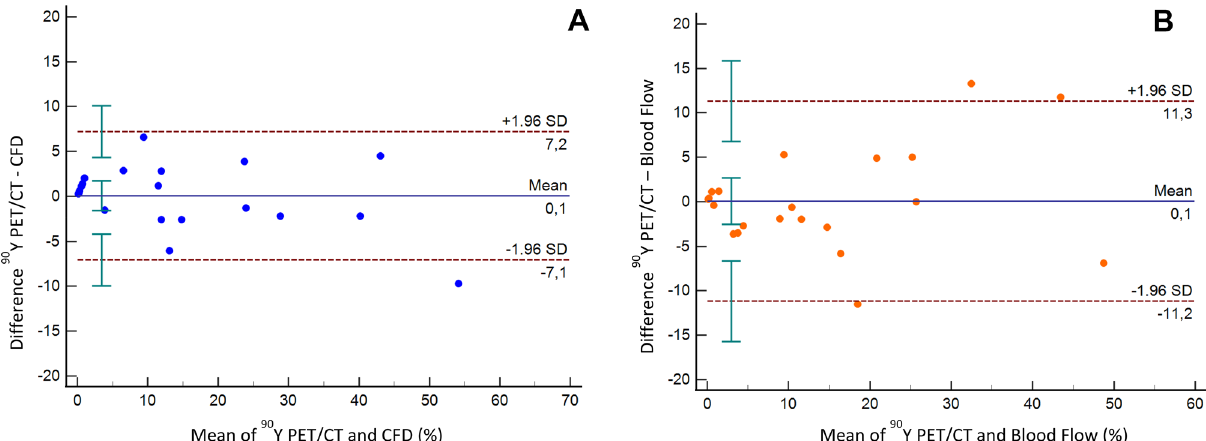
Figure 8. Bland–Altman plots for the differences in distribution in the 21 liver segments studied. ( A ) Difference between in vivo ( 90 Y PET/CT) measured activity distribution and in silico (CFD) simulated activity distribution (%). ( B ) Difference between in vivo ( 90 Y PET/CT) measured activity distribution and prescribed blood flow distribution (%). Solid blue lines indicate the mean of differences, dotted lines indicate upper and lower limits of agreement (LoA) and error bars the 95% confidence interval for both the upper and lower LoA and the mean